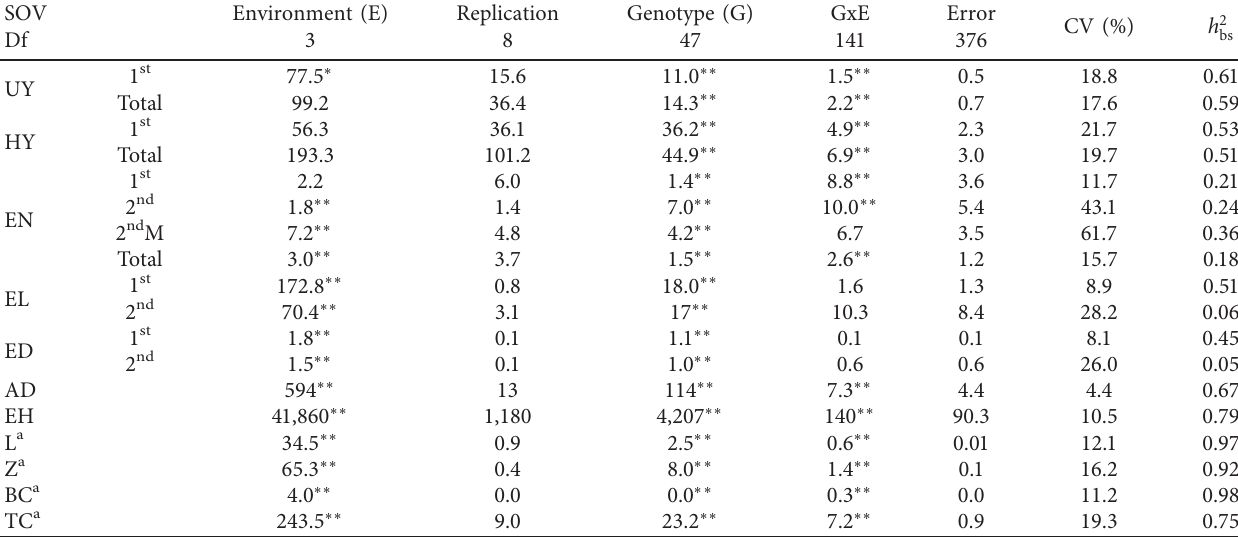
Table 2: Mean squares for yields, yield components, agronomic traits, and carotenoids of 48 small-ear waxy corn genotypes evaluated across four environments in Thailand between 2018 and 2019.